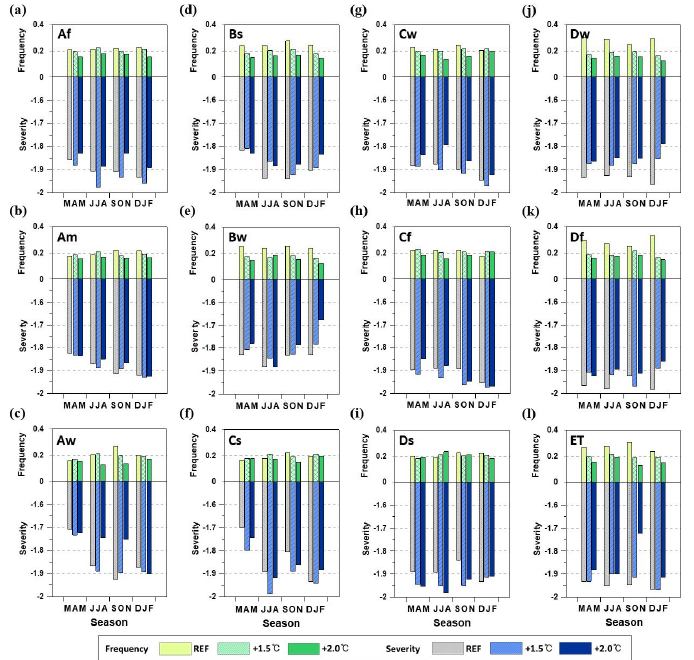
Figure 12. ( a – l ) Seasonal mean frequency of severe drought and severity of severe drought based on SPI3 under reference (REF) and future (+1.5 °C and +2.0 °C) climate scenarios for individual 12 climate on SPI3 under reference (REF) and future ( + 1.5 ◦ C and + 2.0 ◦ C) climate scenarios for individual zones. 12 climate